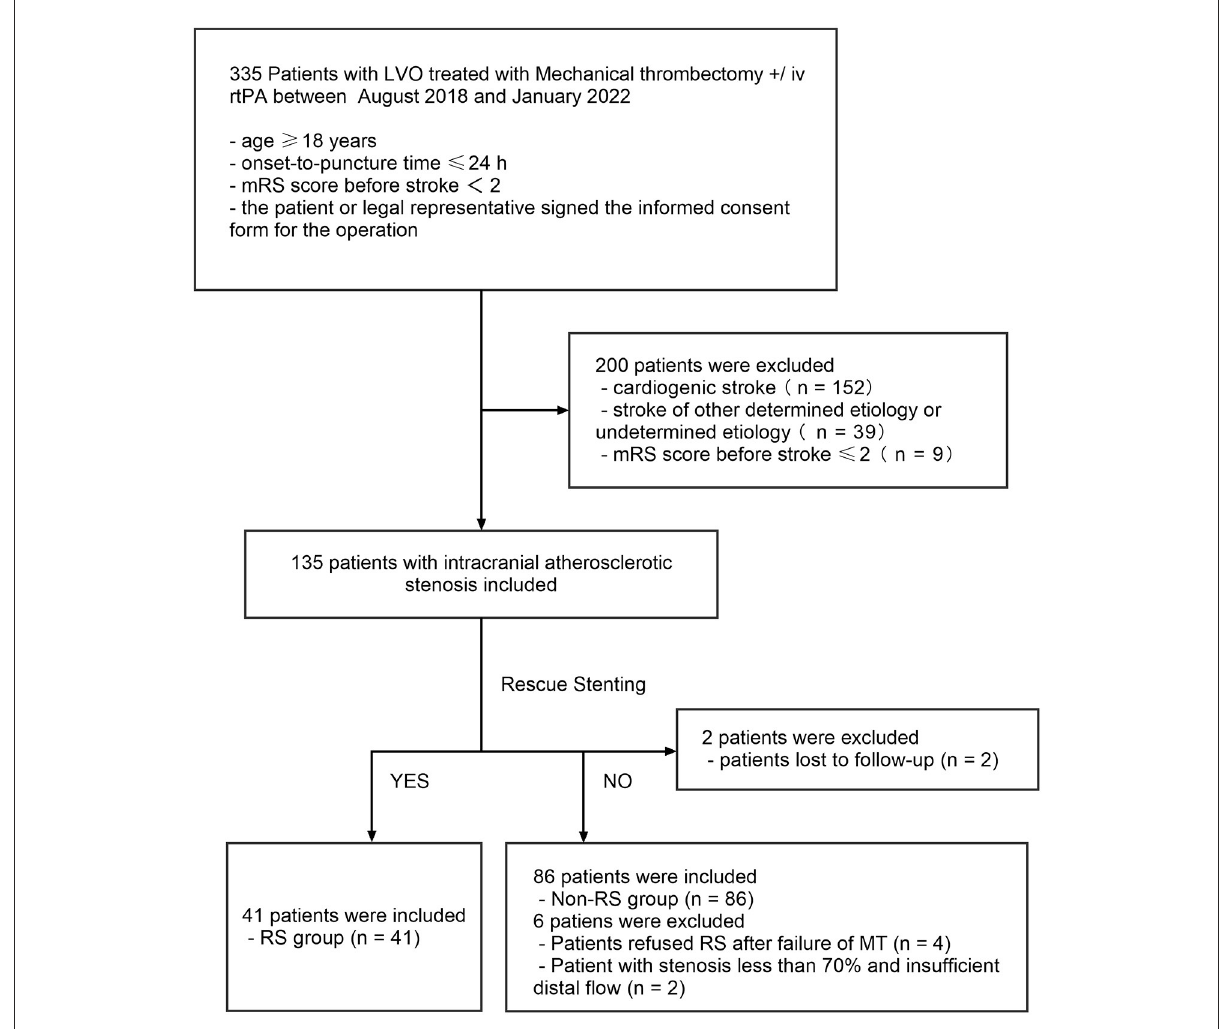
FIGURE3 Flow chart of patient inclusion in the study. LVO, intracranial large vessel occlusion; RS, rescue